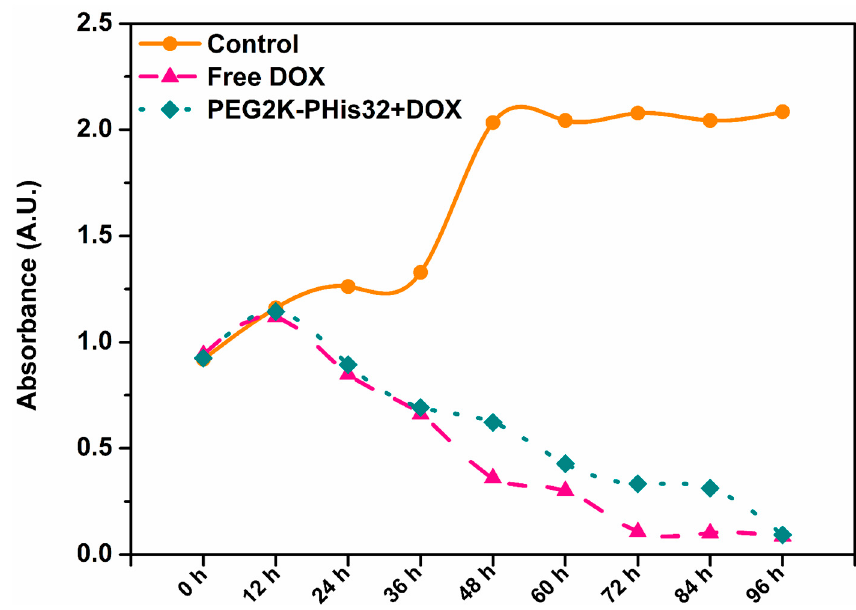
Figure 10. The dynamics of cell viability. Each measurement was done in 8 wells per group and per time